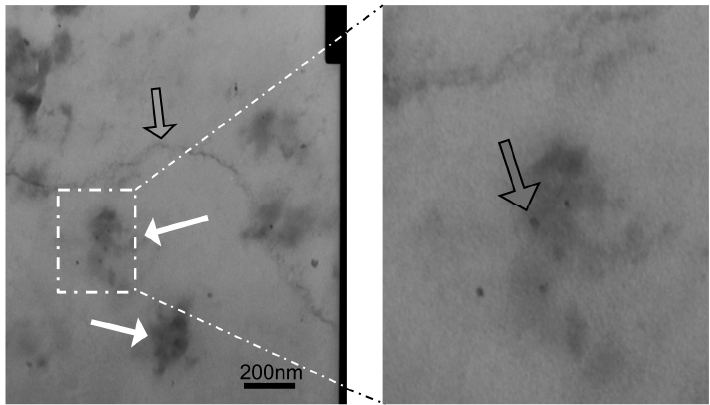
Figure 4. Localization of HER2 targeted PCSNs. TEM image of TEM micrographs showing HER2 targeted PCSNs localization (white arrow) on the surface of the cell membrane (grey arrow) of SK-BR3 cells ( left ). The portion surrounded by a rectangular frame is magnified ( right ).